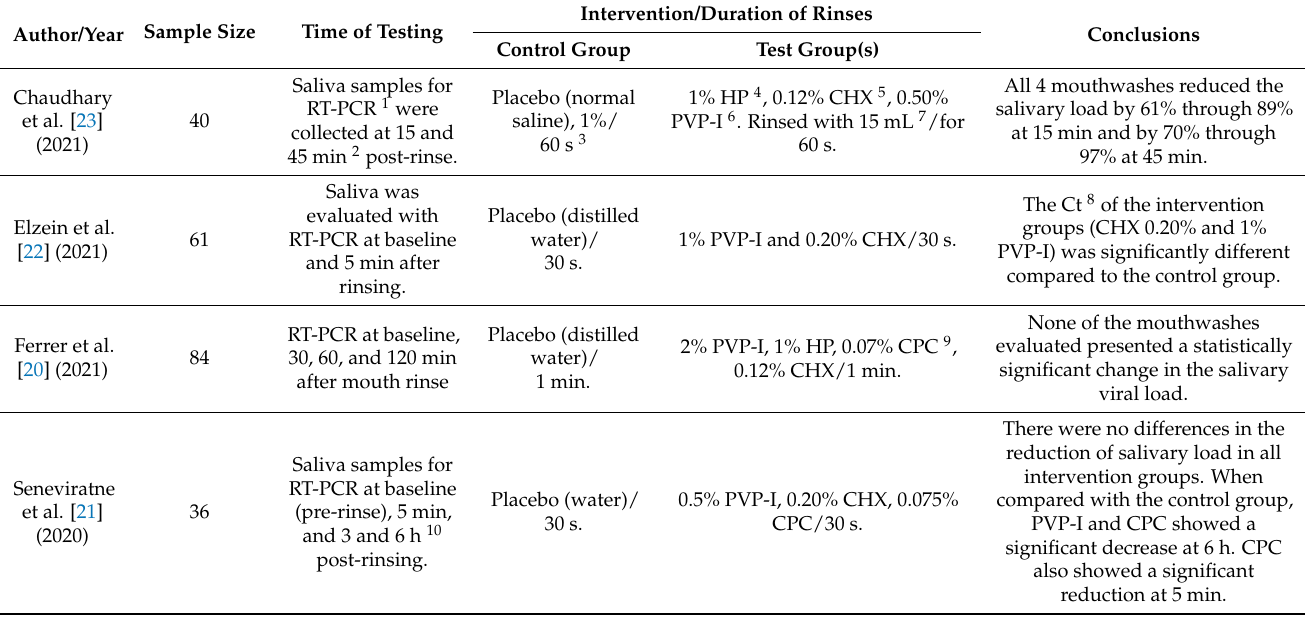
Figure 1. PRISMA ® flow diagram of the search processes and results. A summary of the findings of the included articles is described in Table 1. Table 1. Results of the included